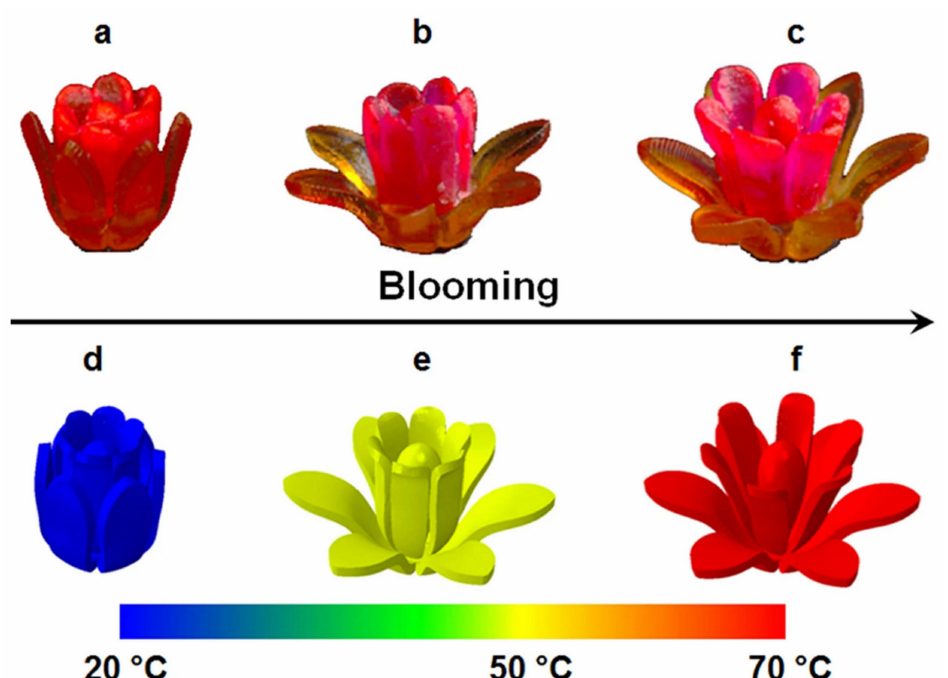
Figure 12. Schematic shows the different shapes of multimaterial flower at various temperature. The flower displays ( a ) bud stage at 20 ◦ C, ( b ) opening of outer petals at 50 ◦ C and ( c ) completely bloomed at 70 ◦ C. ( d – f ) FE simulations of the corresponding flower blooming process. (Reproduced with permission from [95] CC-BY License